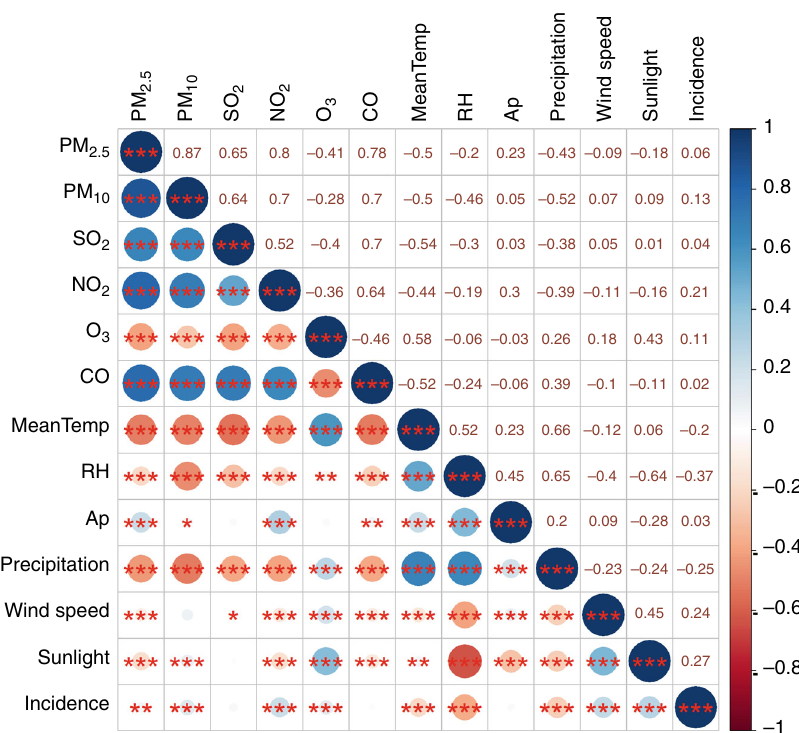
Fig. 4 Pearson correlation coef fi cients between air pollution concentrations and weather conditions and scarlet fever incidence in China, 2013 – 2018 ( n = 2232). PM 2.5 particulate matter with aerodynamic diameter <2.5 μ m, PM 10 particulate matter with aerodynamic diameter <10 μ m, SO 2 sulfur dioxide, NO 2 nitrogen dioxide, O 3 ozone, CO carbon monoxide, MeanTemp mean temperature, RH relative humidity, AP air pressure. *means 0.05 ≥ p > 0.01; **means 0.01 ≥ p > 0.001; ***means ≤ 0.001. Source data are provided as a Source Data fi